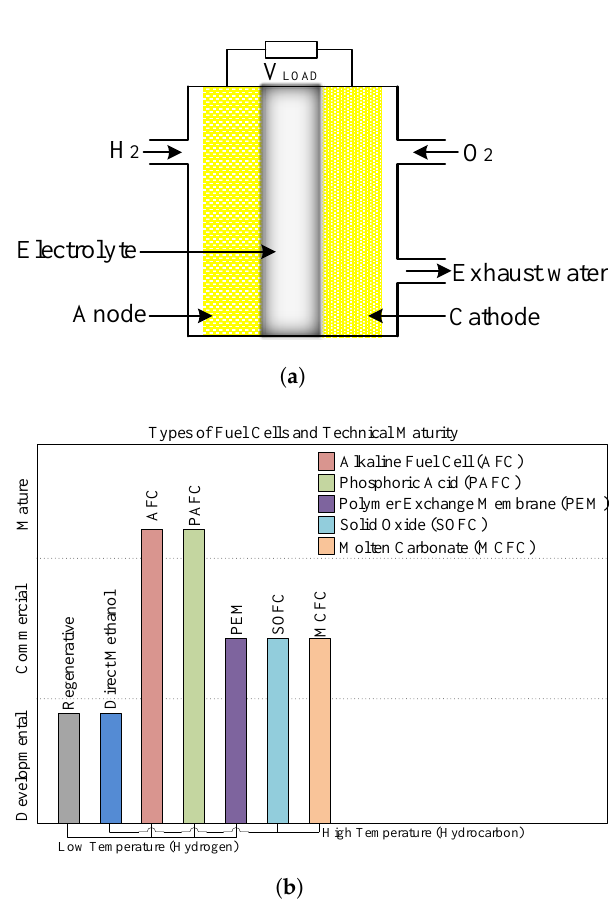
Figure 9. ( a ) Individual structure of Fuel cell and ( b ) Different types of fuel cell and their technical